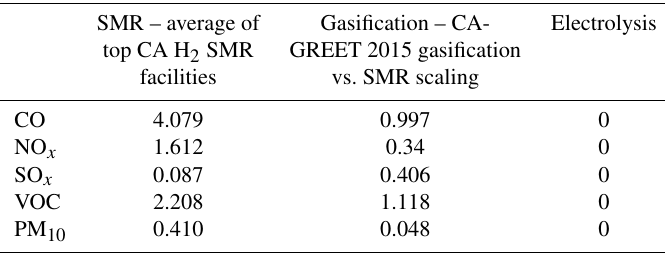
Table 4. Pollutant emissions rate associated with hydrogen production. Units are micrograms of pollutant per kilojoule of hydrogen